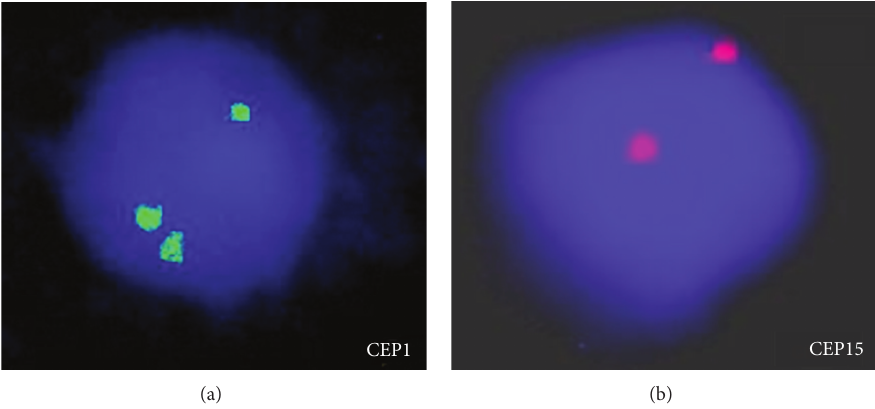
Figure 2: (a) Trisignal for chromosome 1 centromere. (b) Two signals for chromosome 15